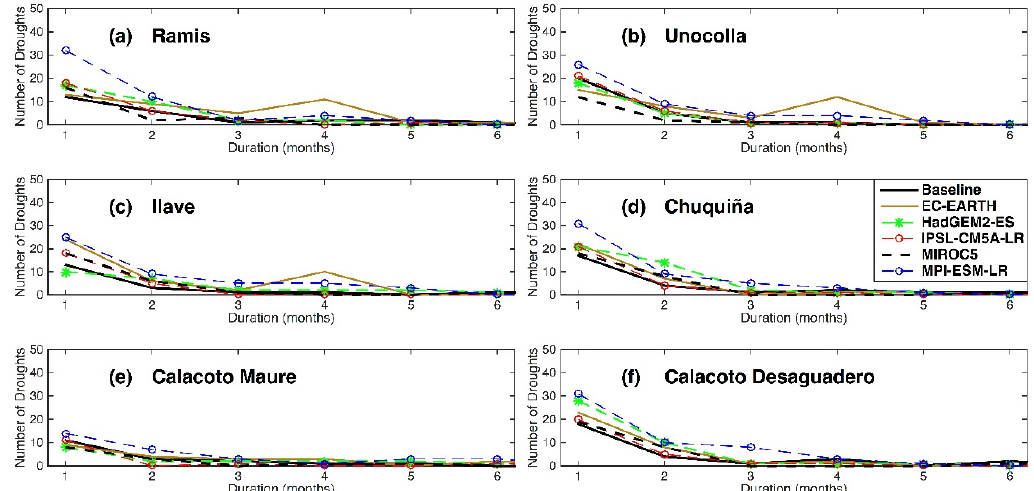
Figure 11. Frequency of hydrological droughts according to their duration. Results for baseline and futures scenarios defined by five selected GCM are shown for six sub-basins controlled at the following stations: ( a ) Ramis (1), ( b ) Unocolla (2), ( c ) Ilave (3), in Peru, and ( d ) Chuquiña (7), ( e ) Calacoto Maure (6), ( f ) Calacoto Desaguadero (5), in Bolivia. Numbers in parentheses indicate the location of control points in Figure 1b.